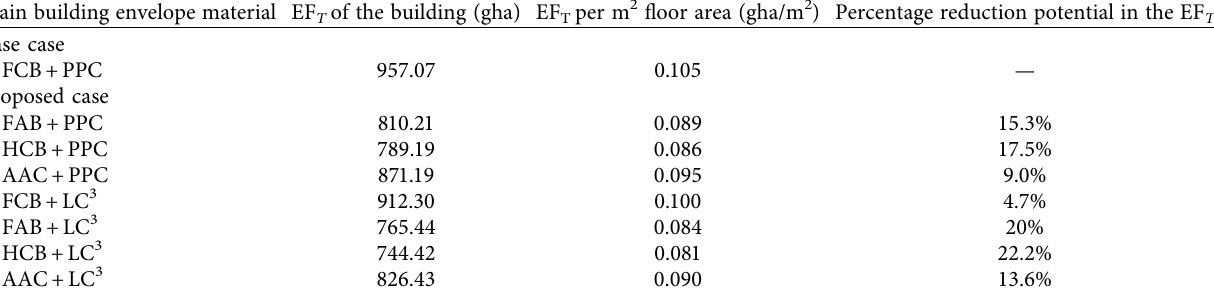
Figure 8: The EF T of campus building based of different construction materials. Table 13: The EF T of the building by used on different construction